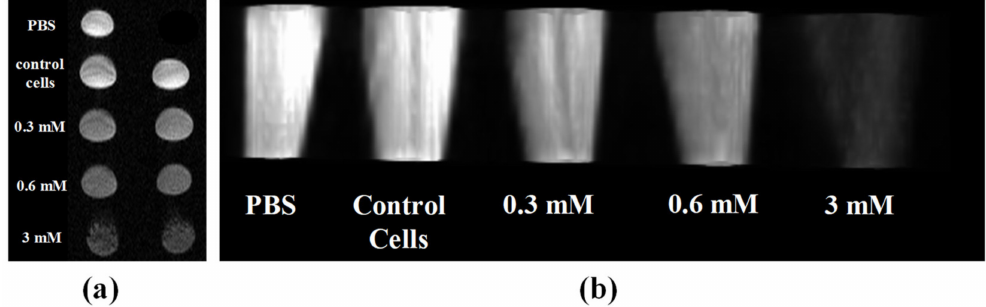
Figure 7. MRI of phantoms were performed to measure the T 2 relaxivity of the SPION complex-labeled cells. ( a , b ) Transversal and longitudinal T 2 -weighted images of HeLa cells incubated with varied concentration of